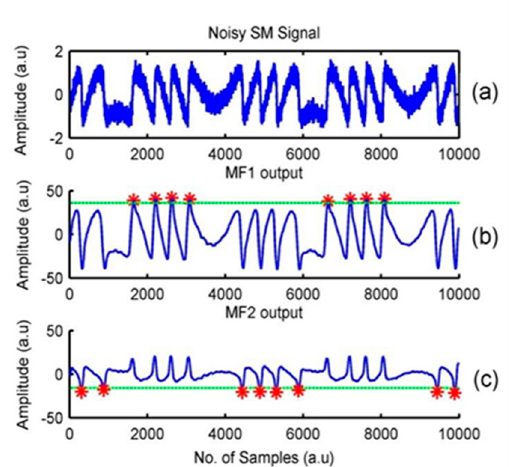
Figure 1. ( a ) Noisy SM signal ( b ) Output of matched filter 1 (MF1) designed for detecting forward SM fringes ( c ) Output of matched filter 2 (MF2) designed for detecting backward SM fringes (dotted green horizontal line represents threshold while red stars represent fringe detection).